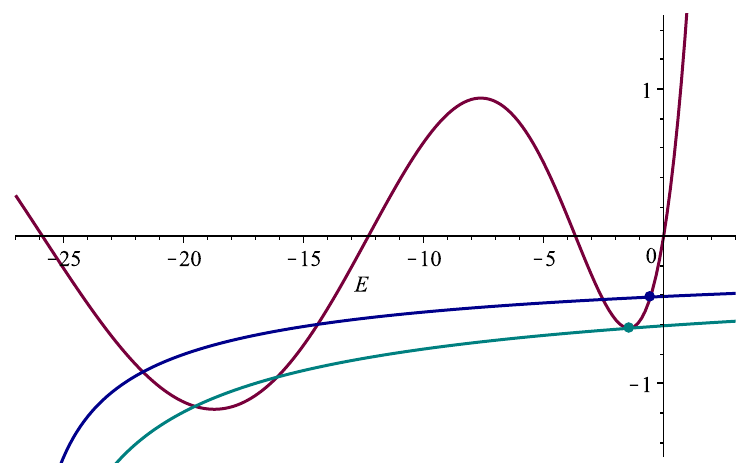
Figure 1 . The threshold energy E 0 is determined by the equation (3.1). The red curve represents √ √ (cid:17) (cid:16) the graph of EI 1 2 E while the blue and green curves are the graphs of − t/ t = 3 and t = t c ≈ 4 . 46 respectively, where we set ξ = 27 . As we see in this example, (3.1) could have multiple real solutions. The threshold energy E 0 is determined as the largest real solution, as indicated by a dot. The horizontal location of the green dot gives the critical value E c